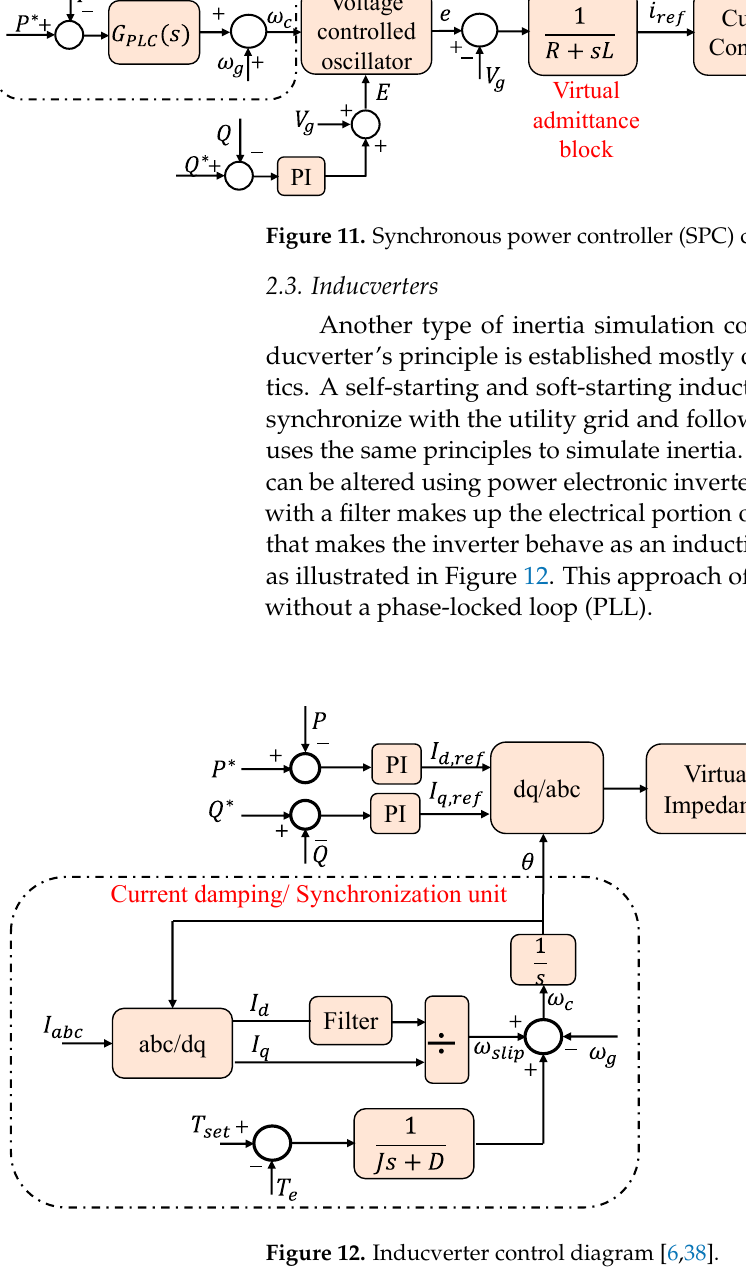
Figure 11. Synchronous power controller (SPC) control diagram [6].